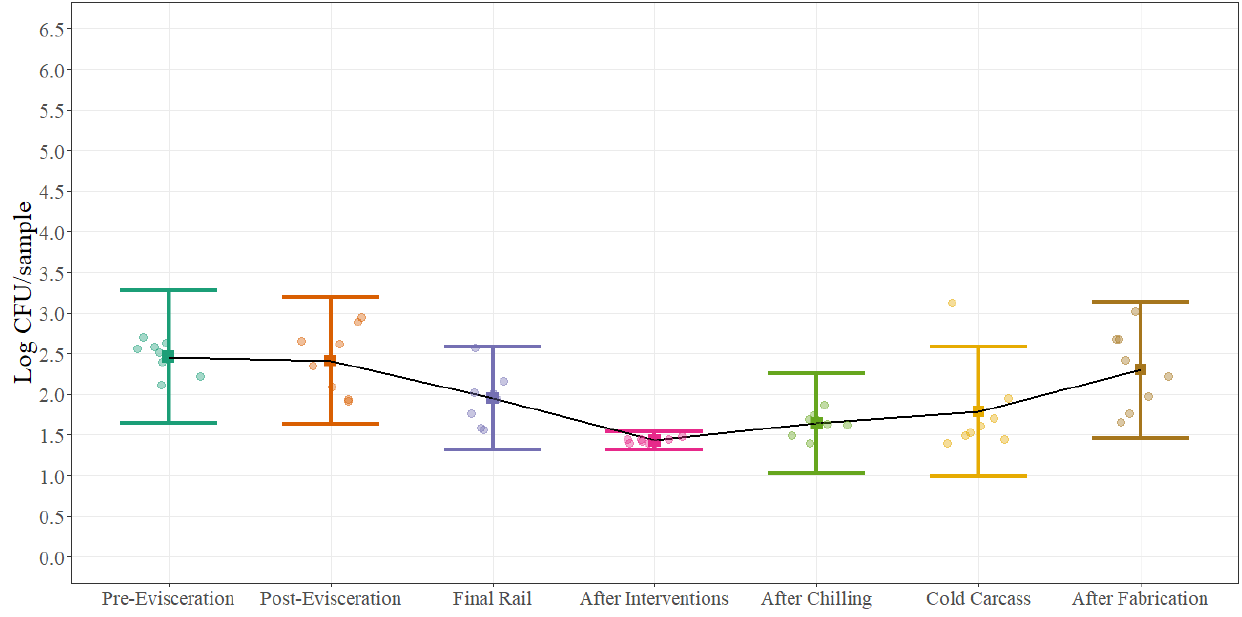
Figure 6. Statistical microbial process control for Escherichia coli (EC) (Log CFU/sample; equivalent to Log CFU/100 cm 2 ) at different sampling locations on the beef processing line. Solid squares represent the mean of each sampling point for all carcass regions and error bars represent ± 3 standard deviations around the mean using a sample size of 12 swabs for each microorganism. The black solid line represents the change on the average of each sampling point throughout the beef processing line for each microorganism.